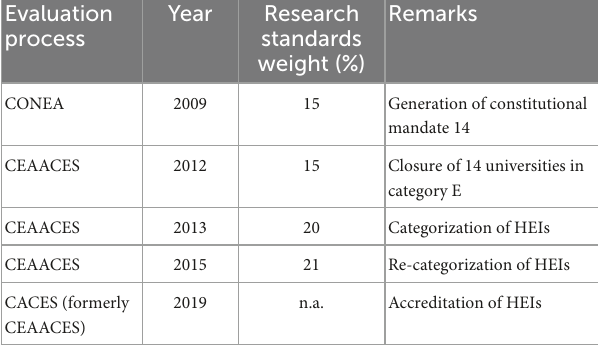
TABLE 1 The historical weight (%) of research on the evaluation